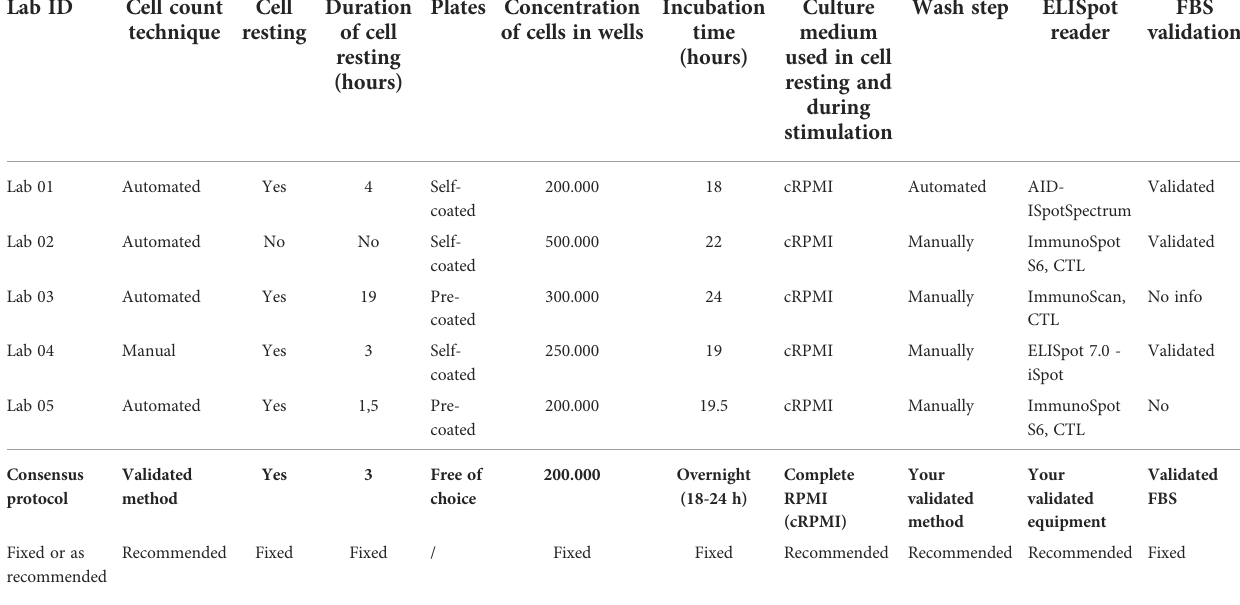
TABLE 1 Overview of the parameters that were identi fi ed as potentially critical for the outcome of the IFN- ɣ ELISpot assay. Lab ID